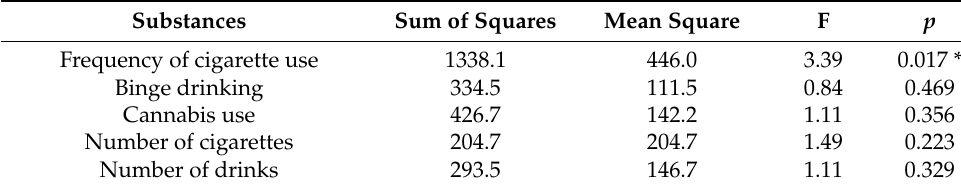
Table 5. Between-groups mean comparisons of fear of COVID-19 infection by substance